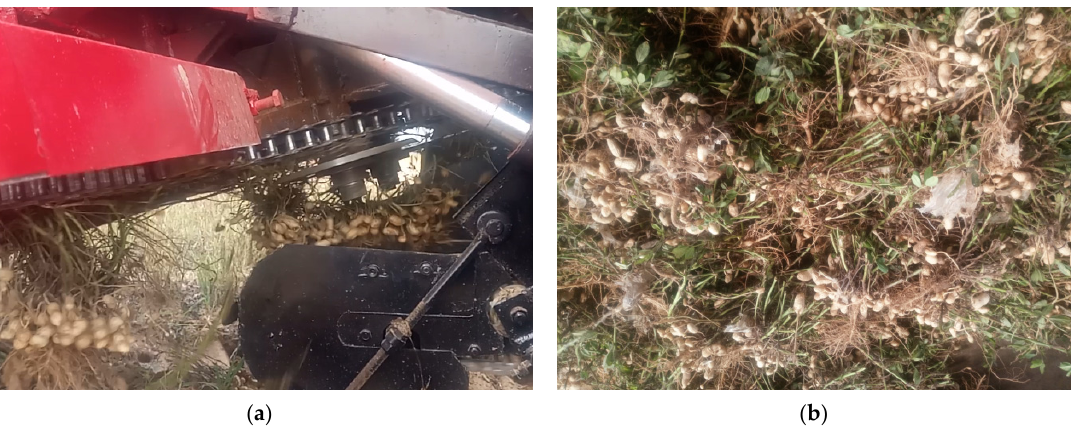
Figure 8. Acquisition of peanut root disk. ( a ) The front-end double disc cu tt er of the combine har- vester separates the peanut root disk from the peanut plant. ( b ) Peanut root disk. Fifty peanut root disks were used, and the measured plant parameters were averaged to obtain the parameter values of the peanut root disks, as shown in Table 1. In the test, the pod-picking inclination angle of the longitudinal axial fl ow pod-picking device was determined to be 20° according to the combined harvester for peanut seedlings and pea- nuts. Table 1. Parameters of the peanut root disk. Stubble Height (mm)